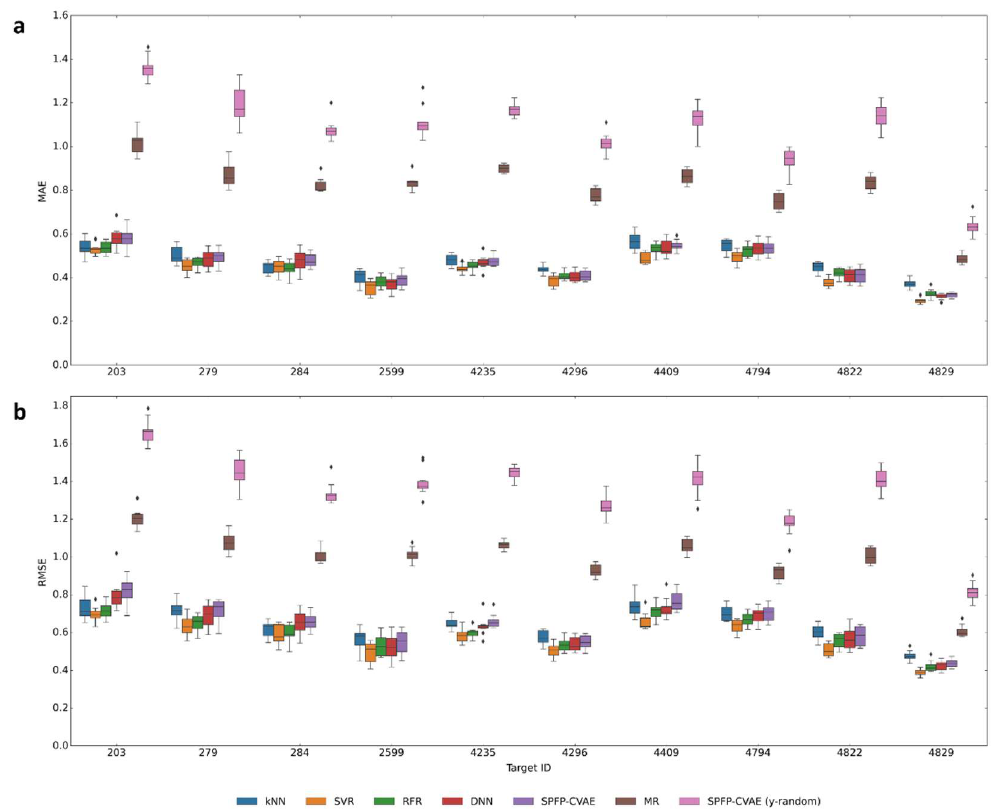
Figure 6. Prediction accuracy. Boxplots report the ( a ) MAE and ( b ) RMSE values for potency predictions using different ML models across all activity classes.